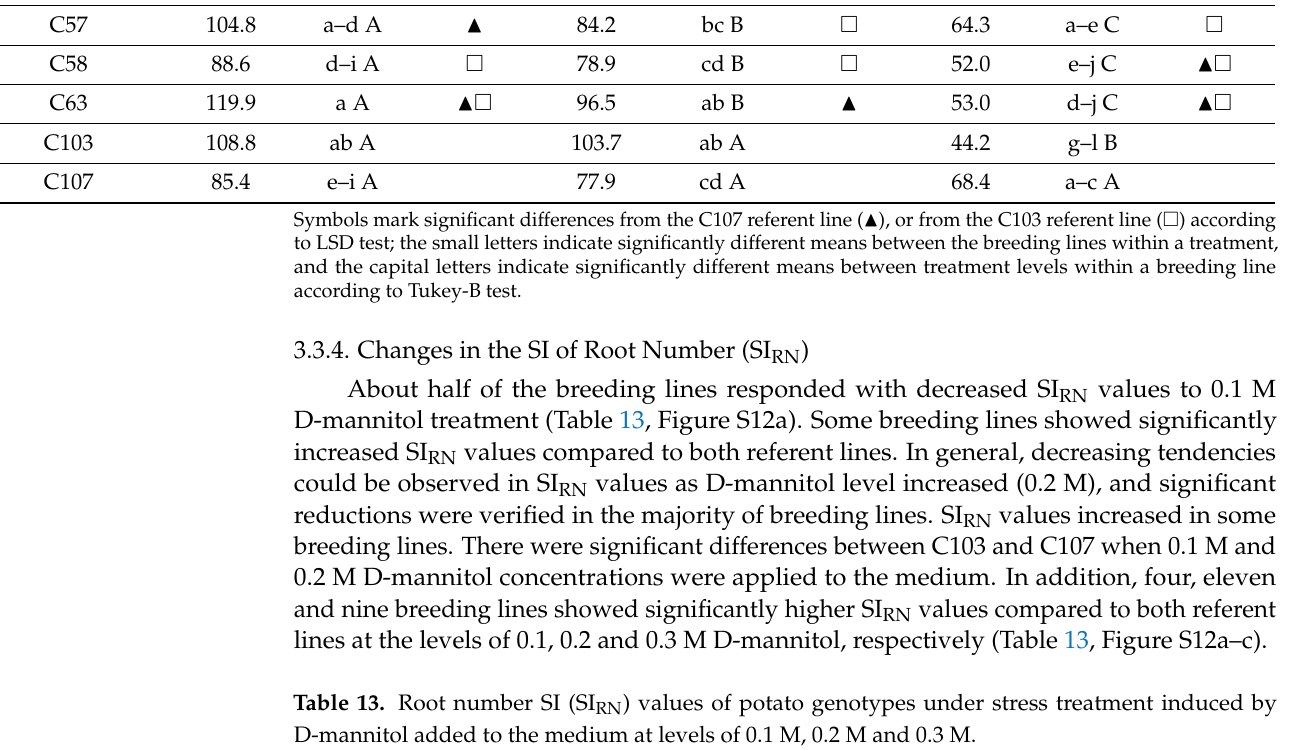
Table 13. Root number SI (SI RN ) values of potato genotypes under stress treatment induced